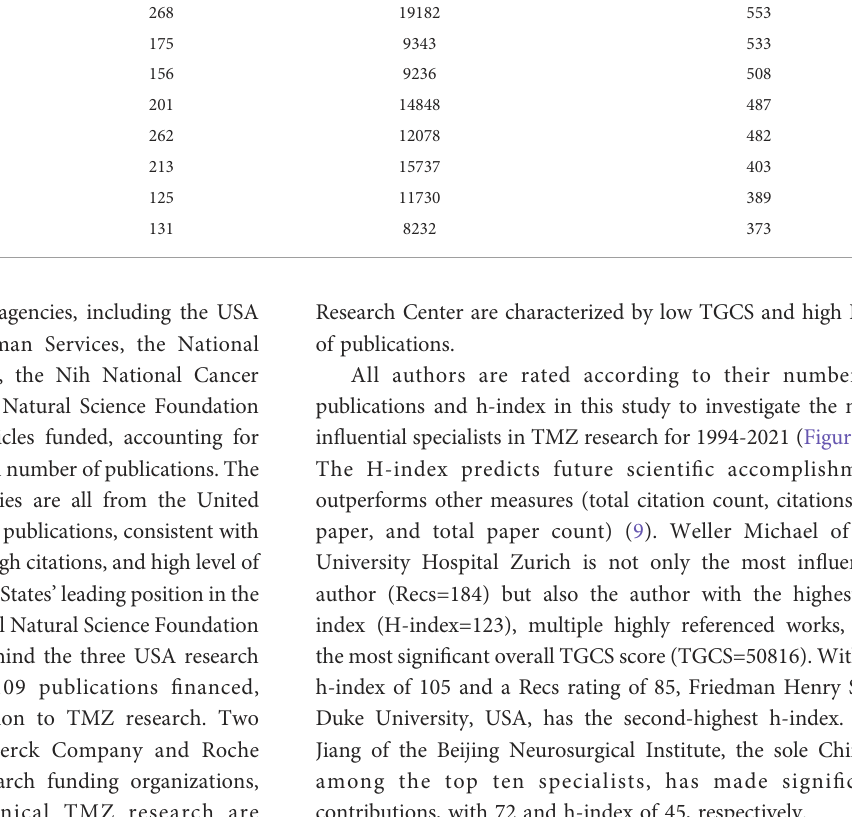
TABLE 2 The top 10 most collaborative